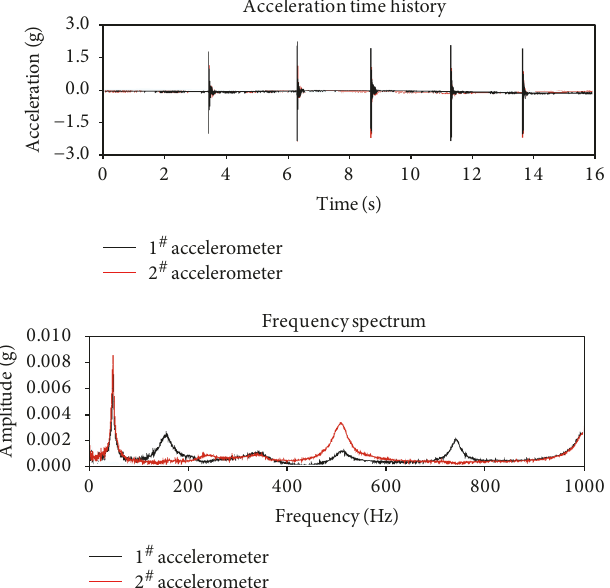
Figure 4: Acceleration time history and corresponding amplitude spectrum.